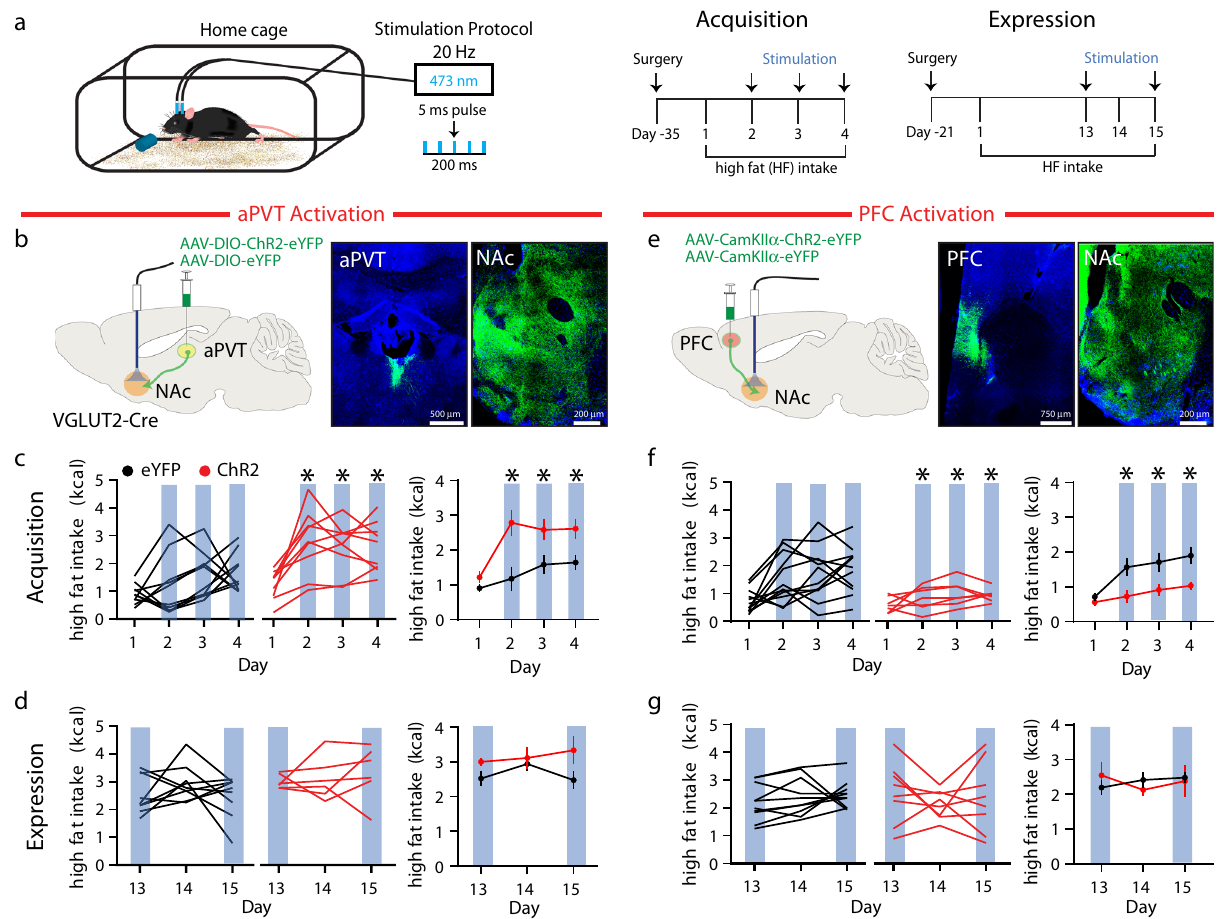
Fig. 1 Activation of distinct NAc glutamatergic inputs has opposing effects on high fat intake. a Schematic of experimental setup (left); experimental timeline (right). b Schematic of viral injection and ferrule implant for aPVT input stimulation (left); representative images of ChR2 infection in the aPVT and NAc (right). c , d Quanti fi cation of high fat intake during acquisition ( c : F 1,17 = 13.1 P = 0.002, n = 10, 9 mice/group) and expression period ( d : F 1,13 = 4.03, P = 0.07, n = 9, 6 mice/group) in eYFP control (black) and ChR2 expressing (red) mice. In this and all subsequent fi gure panels, blue bars signify blue light stimulation; left panels illustrate individual subjects; far right panel displays mean ± s.e.m. e Schematic of viral injection and ferrule implant for PFC input stimulation (left); representative images of ChR2 infection in the PFC and NAc (right). f , g Quanti fi cation of high fat intake during acquisition ( f : F 1,18 = 9.03, P = 0.008, n = 10, 8 mice/group) and expression period ( g : F 1,16 = 0.001, P > 0.05, n = 10, 8 mice/group). Data are mean ± s.e.m. * P < 0.05,